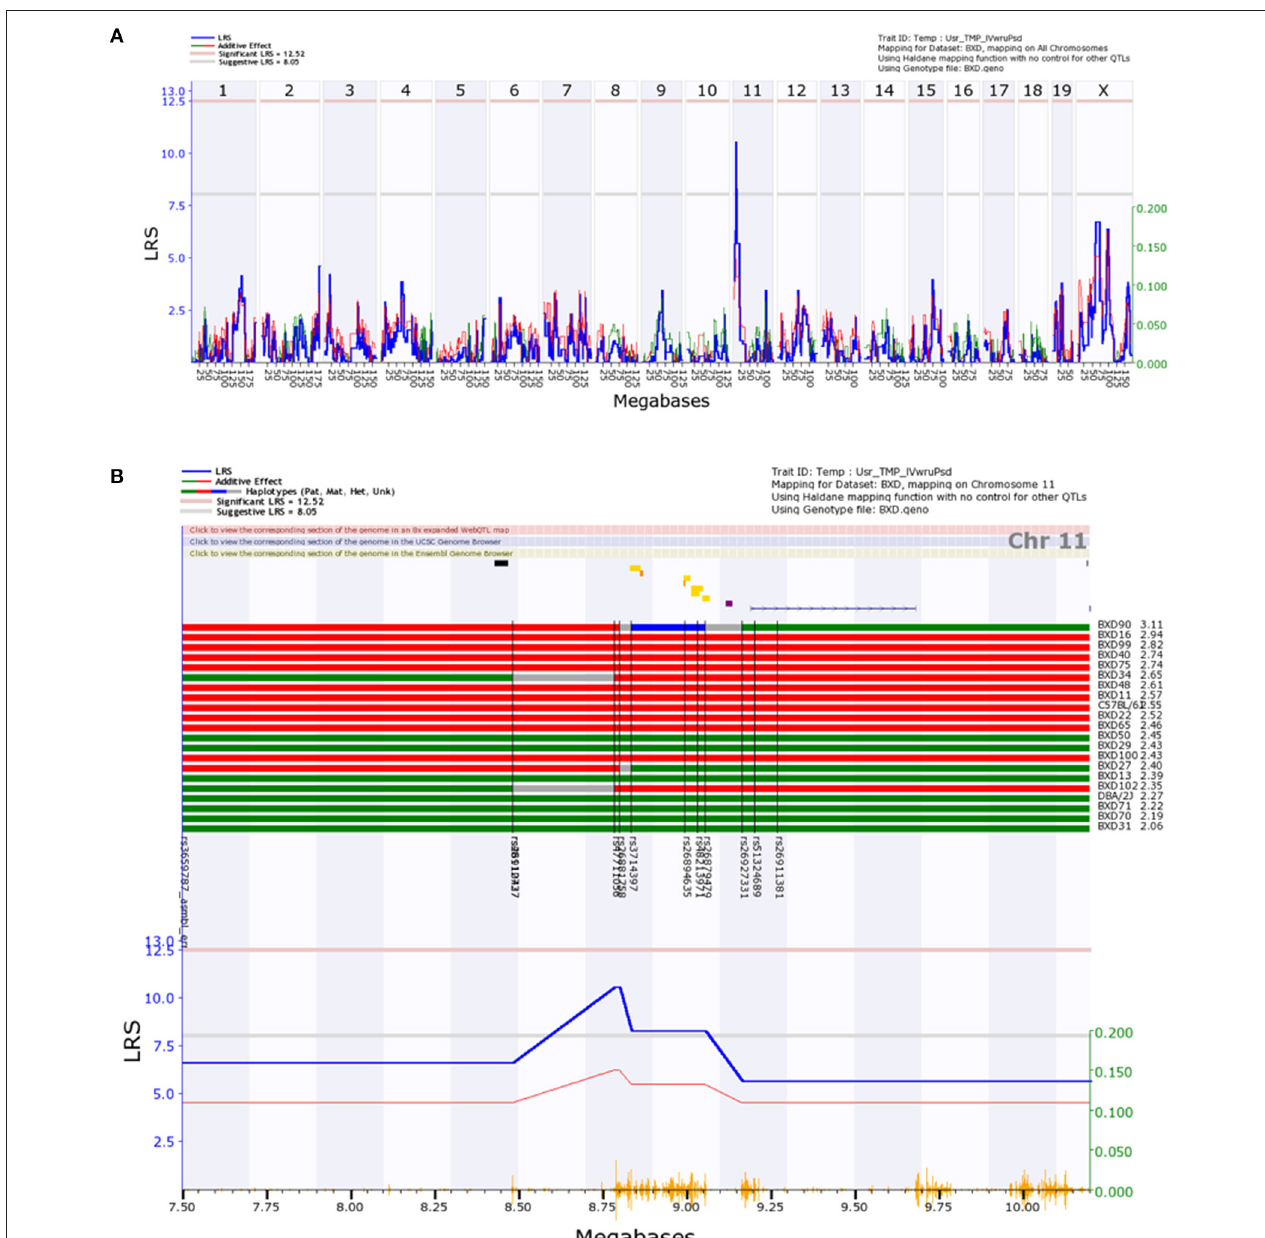
FIGURE 3 | Interval map of normalized ocular compliance ( φ norm ) across the mouse genome, as determined with the Step Response data analysis method. Interpretation of Figure is as described in Figure 2